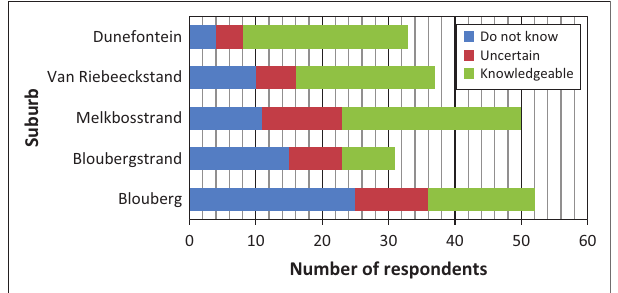
FIGURE 3: Respondents’ knowledge of methods of general-emergency notification.